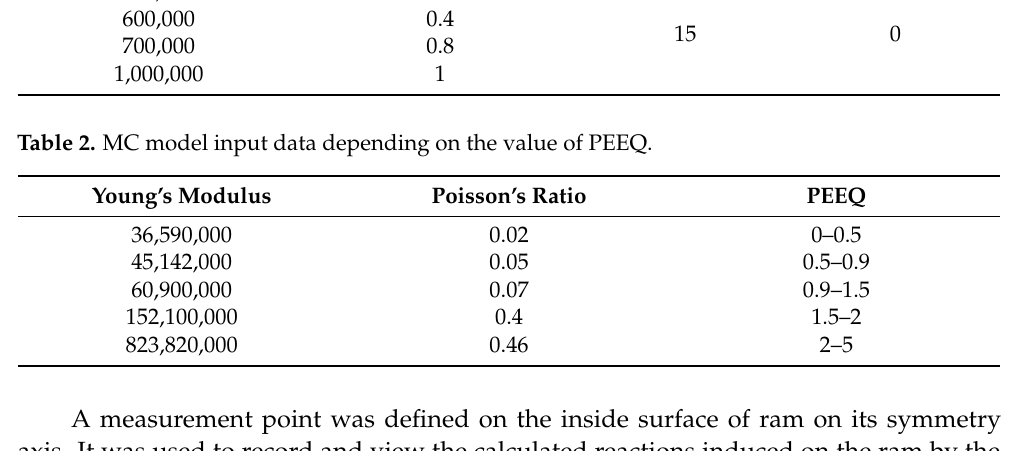
Table 2. MC model input data depending on the value of PEEQ.